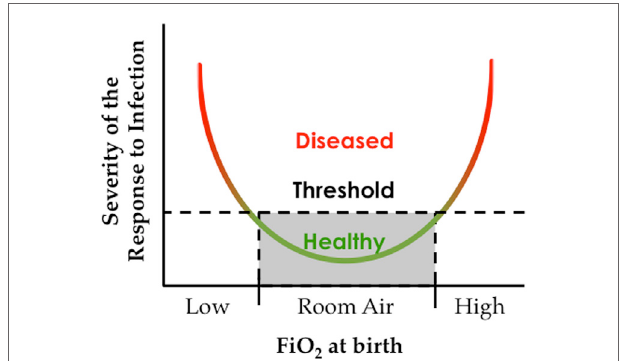
FiGURe 4 | The oxygen environment at birth affects the severity of respiratory viral infection later in life . Hypothetical graph depicting how exposure to low or high inspired oxygen at birth can increase respiratory morbidity following a respiratory viral